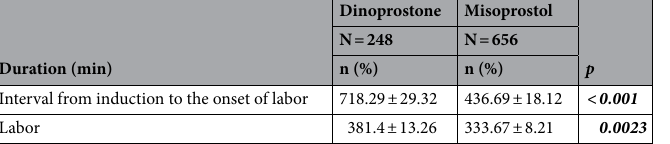
Table 4. Comparison of interval from induction to the onset of labor and duration of labor. Significant values are in bolditalics.